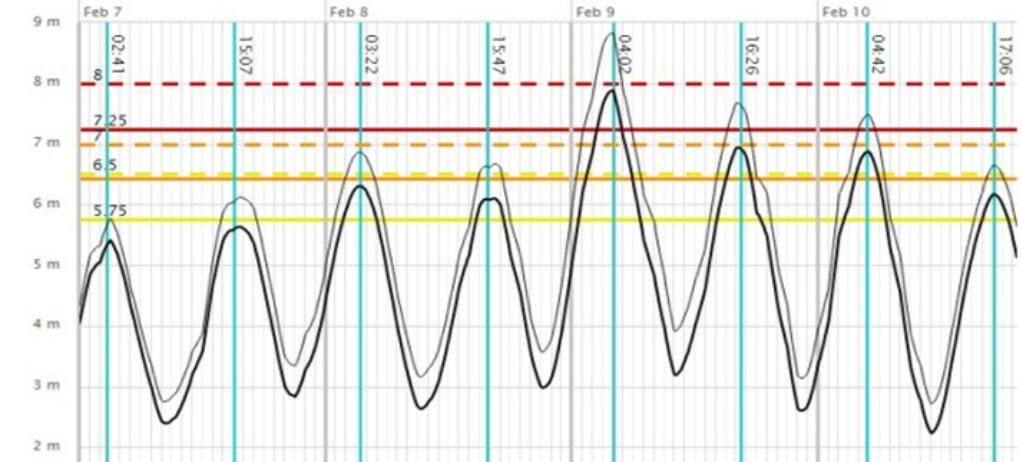
Figure 5. Evolution of overtopping indexes I (black line) and I max (grey) during the episode.